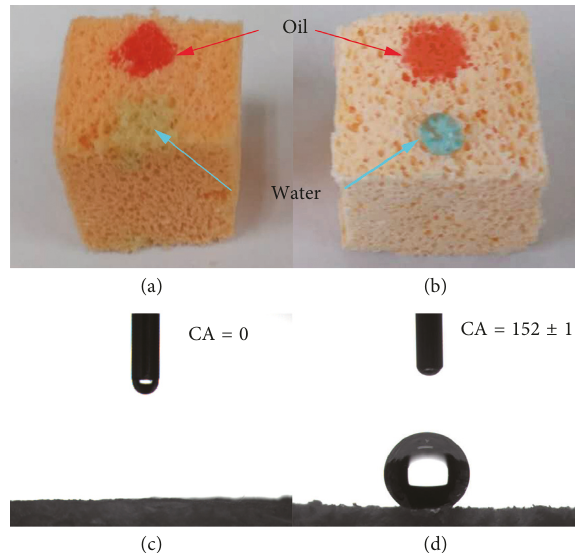
Figure 6: Water (colored blue) and oil (colored red) dropped onto the surface of pure PVA sponge (a) and the silylated PVA sponge (b). WCAs of pure PVA sponge (c) and the silylated PVA sponge (d). Plant oil is colored red with Sudan III and water is colored blue with Methyl blue in advance,